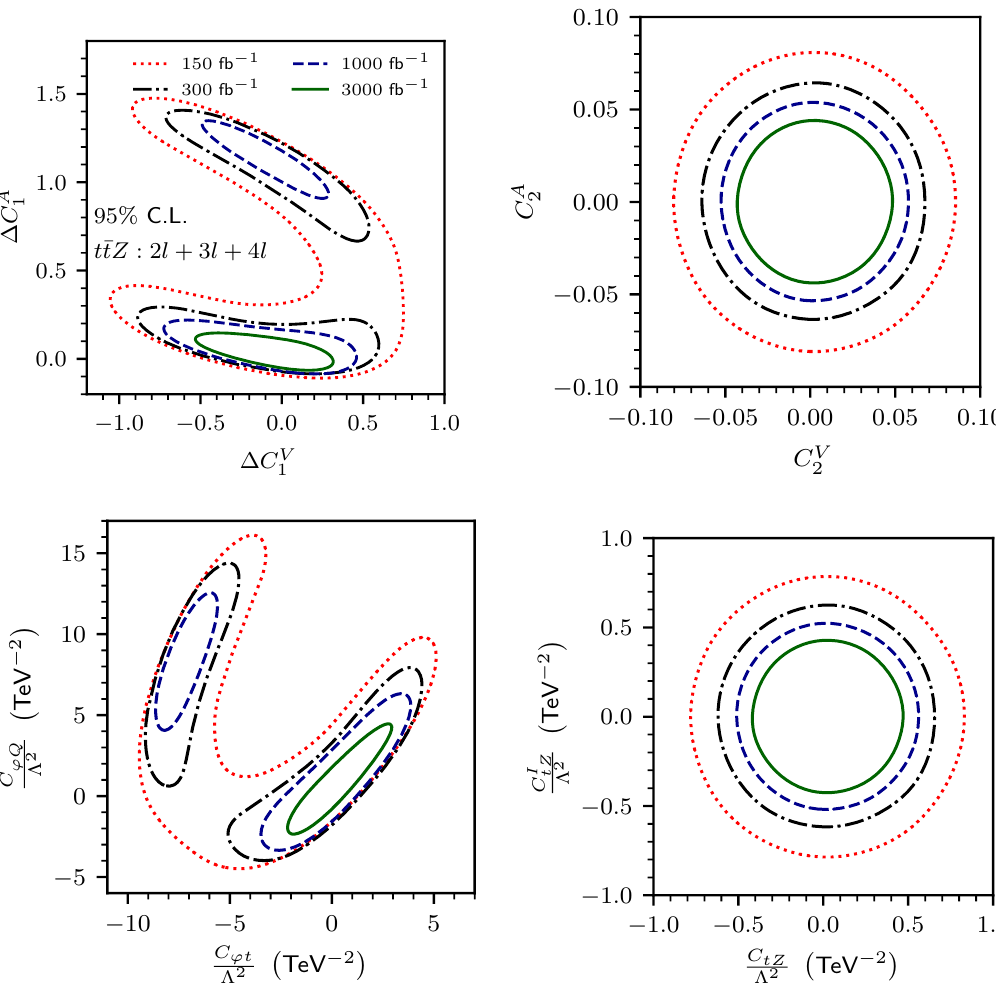
Figure 10 . The 95% C.L. BCI contours from MCMC are shown for the couplings of the effective Lagrangian in eq. (4.1) (in top-panel ) and their translated contours to the couplings of the effective operators in eq. (4.3) (in bottom-panel ) in t ¯ tZ : 2 l + 3 l + 4 l channels for various luminosities at √ s = 13 TeV using the cross section and all